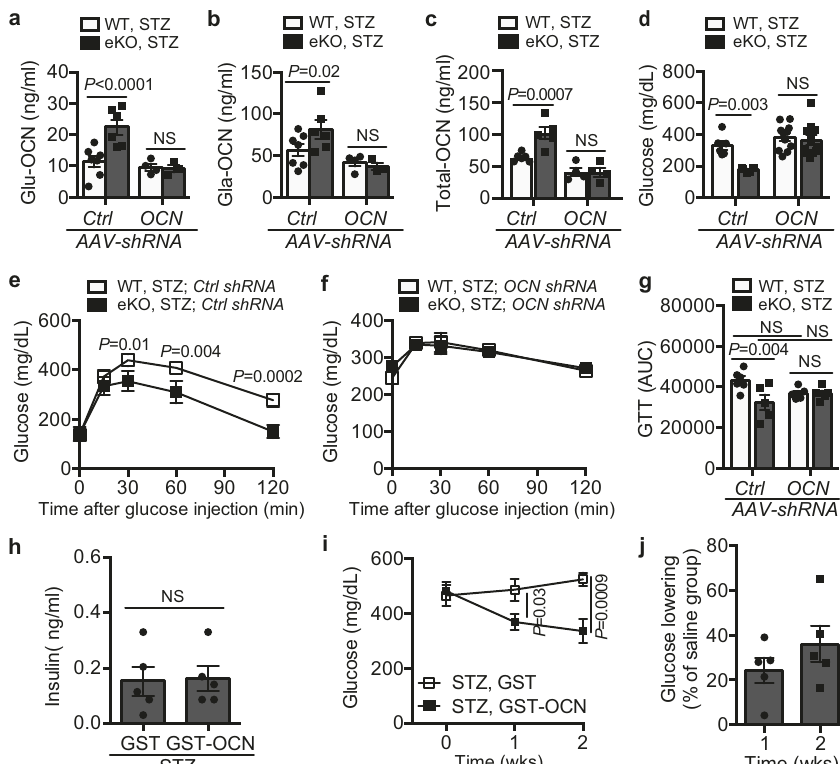
Fig. 7 OCN silencing in vivo inhibits endothelial LRP1 depletion-improved glucose responses. a – d Blood levels of Glu- ( a ), Gla- ( b ) and total OCN ( c ), and non-fasting glucose ( d ) after AAV-OCN-shRNA or AAV-Ctrl-shRNA injection in mice after STZ treatment. The data for control mice are shown in Fig. 1d. e – g Glucose tolerance tests in AAV-Ctrl-shRNA ( e ) and AAV-OCN-shRNA ( f ) injected mice after STZ-induced diabetes. g Areas under the curve (AUCs) for GTTs. h Blood levels of insulin in saline (containing GST-OCN or GST)-injected STZ mice. The data for non-STZ control mice are shown in Supplementary Fig. 5b. i – j OCN administration alleviates hyperglycemic response in STZ-induced type 1 diabetic mice. The percentage of glucose-lowering in GST-OCN-injected STZ mice compared to GST-injected mice is presented in j . n = 6 ( a – c , WT; d , Ctrl-shRNA; e – g , WT; h ), 5( a – c , eKO, Ctrl-shRNA; e – g , eKO; i, j ), 4 ( a – c , eKO, OCN-shRNA), 11 ( d , OCN-shRNA). NS, not signi fi cant. Data are presented as mean ± SEM. Analysis was two-way ANOVA followed by Fisher ’ s LSD multiple comparison test ( a – g, i ) or unpaired two-tailed Student ’ s t -test ( h , j